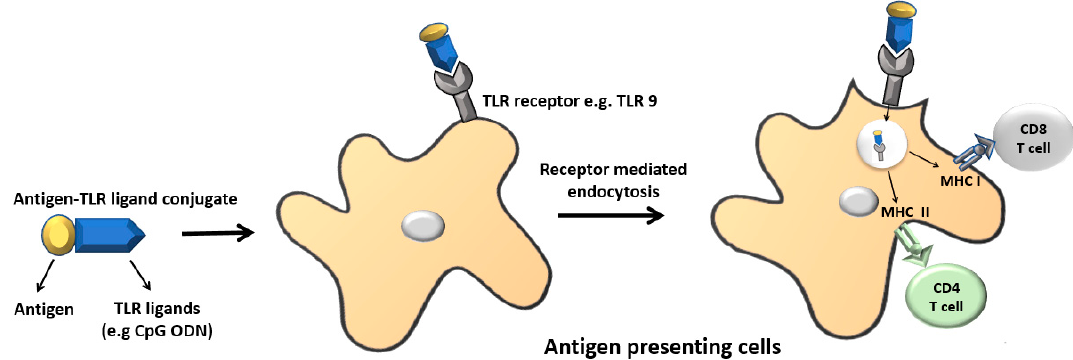
Figure 1. Illustration of ligand-based antigen targeting. Pattern recognition receptor (PRR) ligands can be conjugated to the antigen chemically or recombinantly. In most cases, Toll-like receptor (TLR) ligands have been used for antigen targeting. The TLR ligands have dual functions. They facilitate the targeting of antigens to antigen presenting cells (APCs) and also act as adjuvants. Once the antigen–PRR ligand conjugate binds to the respective receptor on antigen presenting cells, it undergoes receptor mediated endocytosis and is presented either via the MHC I or MHC II pathways. CpG ODN: CpG oligodeoxynucleotide.